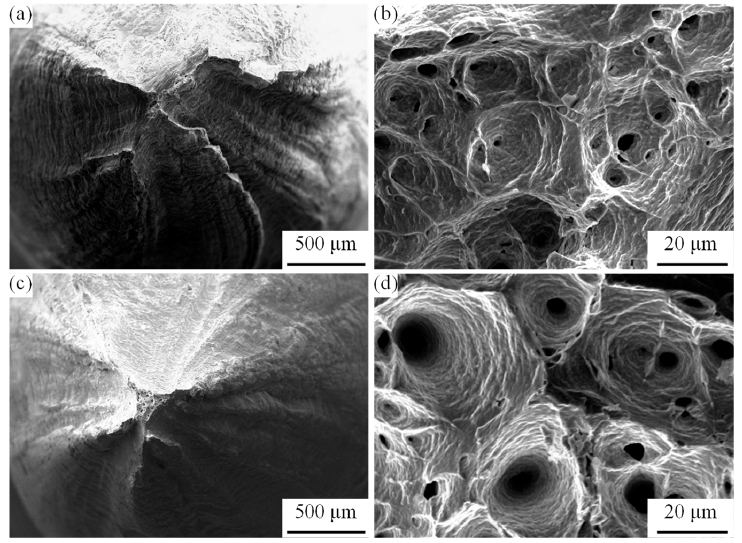
Figure 9. SEM images of the tensile fracture surfaces of the alloys at 750 °C: ( a , b ) 2Zr-4O alloy; ( c , d ) 2Zr-6O alloy. ( a , c ) The entire fracture surfaces; ( b , d ) the enlarged images of fracture surfaces.